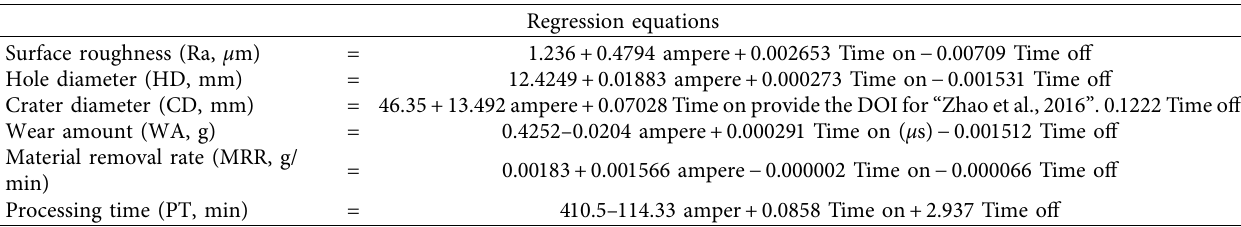
Table 6: Regression equations for output